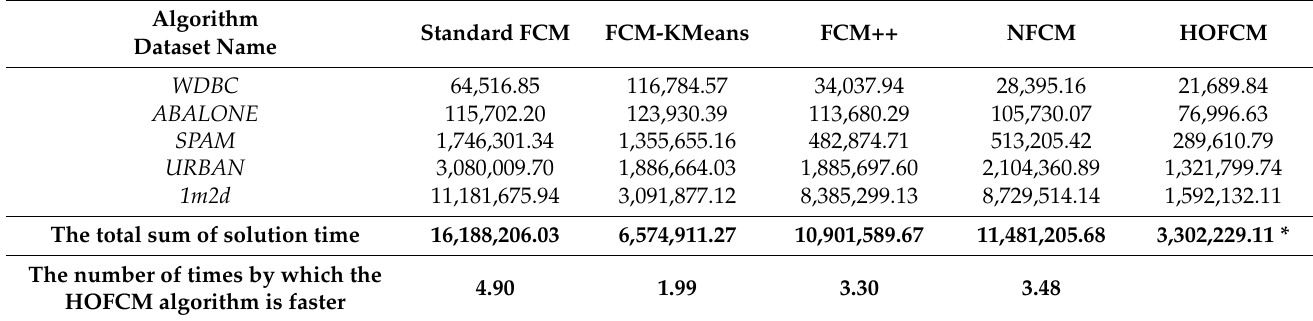
Table 6. Sum of solution times in milliseconds of Experiments I and